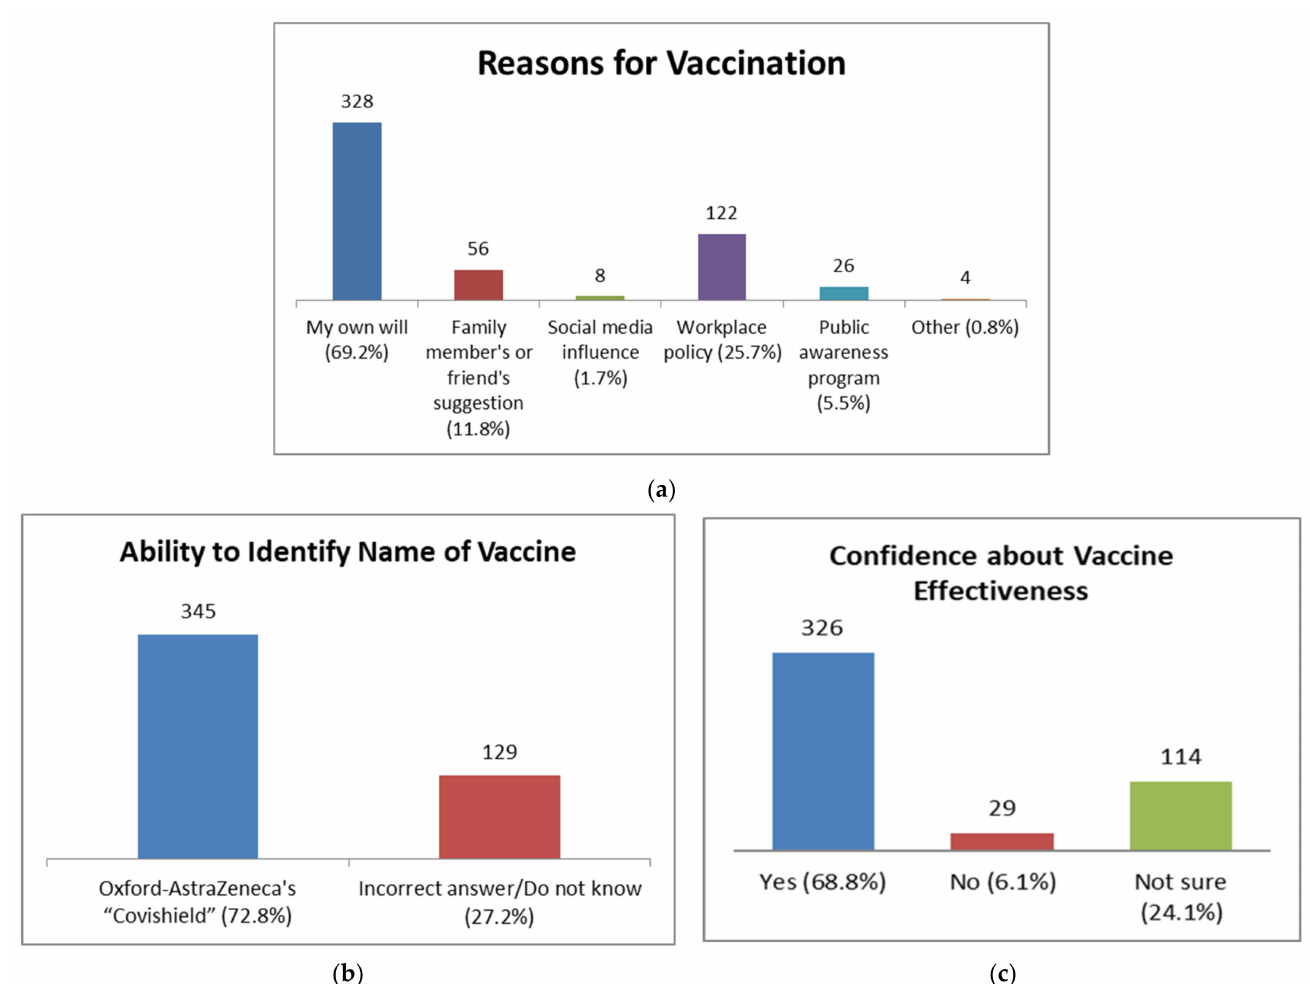
Figure 3. Perceptions of study participants towards COVID-19 vaccines. ( a ) Reasons for vaccination showed that the majority of participants got vaccinated due to their own will. ( b ) Most participants reported being confident about the vaccine’s effectiveness. ( c ) Ability of the vaccine recipients to identify the name of the vaccine. More than one-quarter of study participants could not correctly identify the